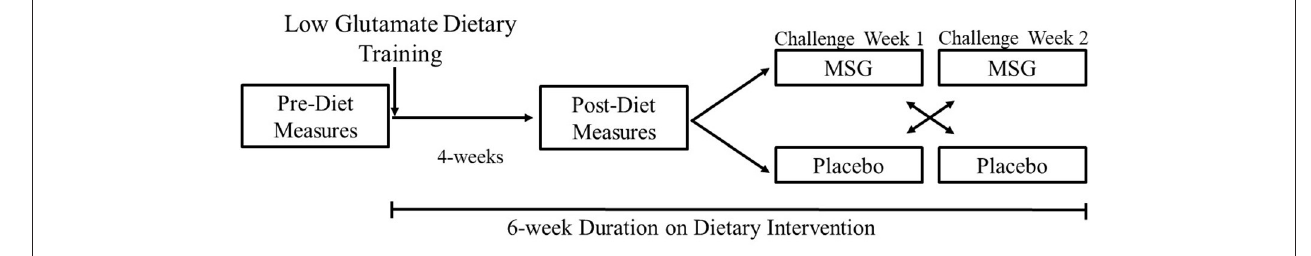
FIGURE 1 | Study protocol diagram.